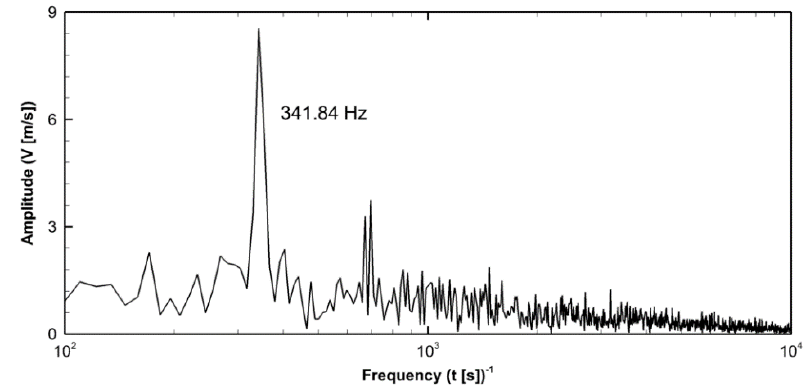
Figure 12. Time history of velocity magnitude at (6 mm, − 10 mm, 0) for the mass fl ow rate of 6.8039 g/s.